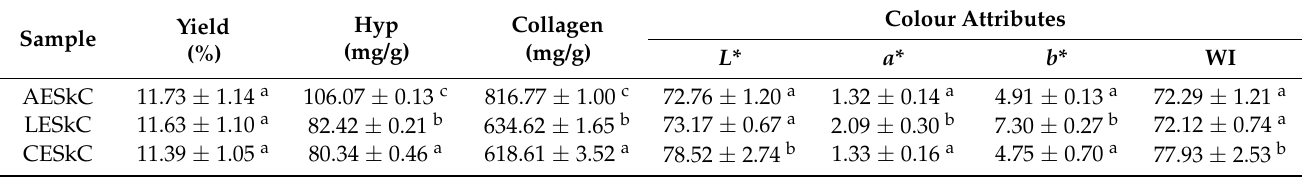
Table 1. Yield, Hyp, collagen, and color analysis of the lizardfish skin collagen extracted with various organic